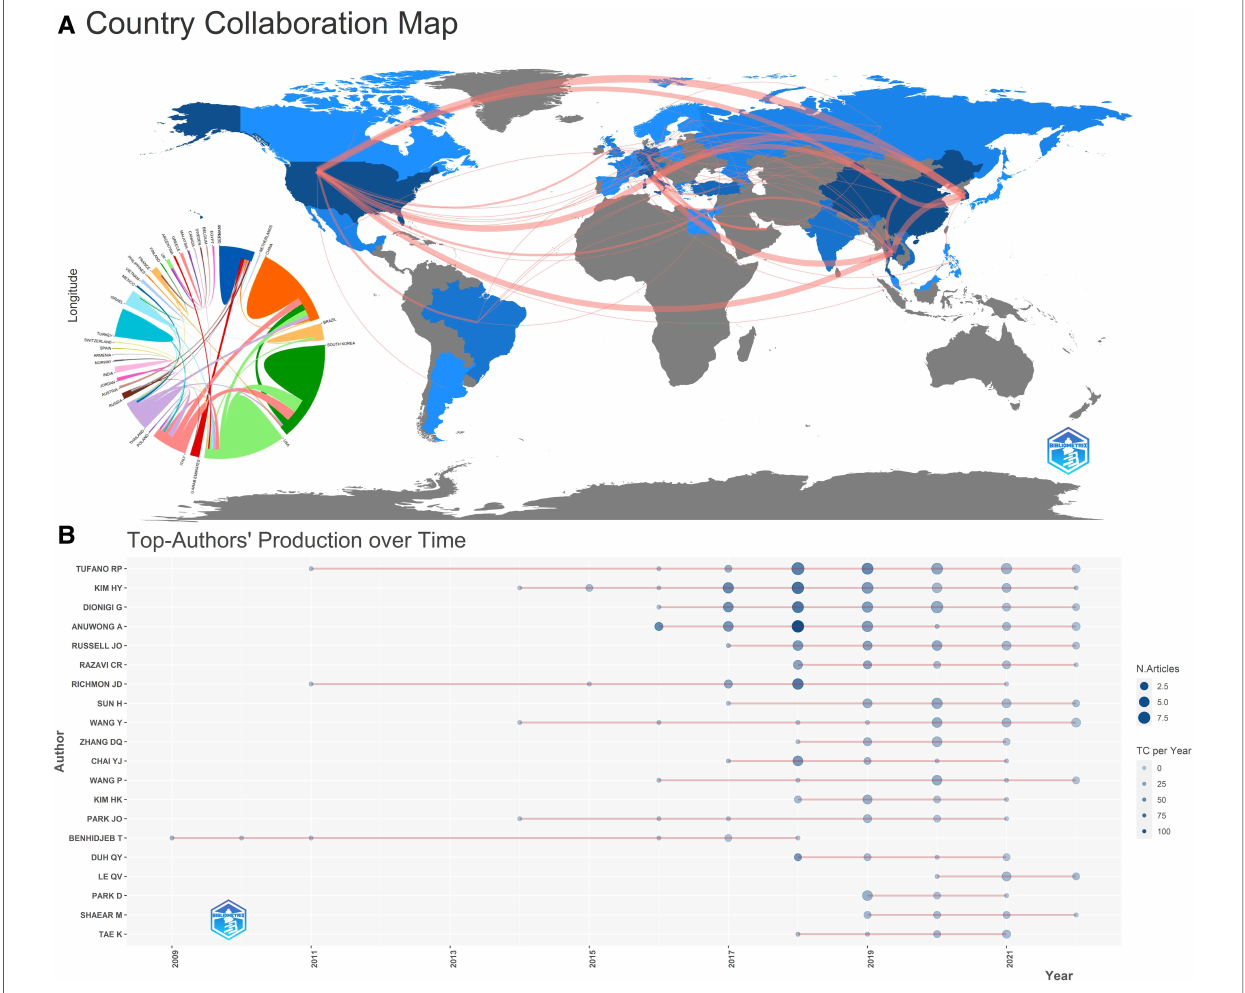
FIGURE 2 ( A ) national cooperation map. The connection represents the cooperation between countries. The darker the color, the greater the number of articles. ( B ) Top-author ’ s production over time. TC, total